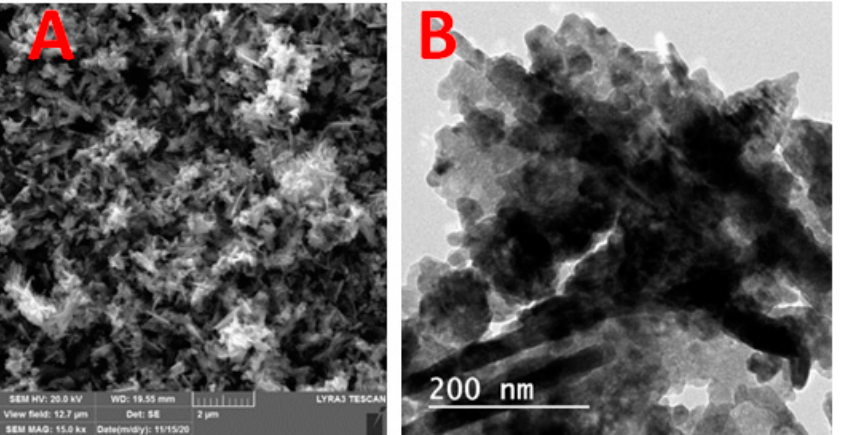
Figure 1. X-ray diffraction pattern of green biosynthesized ZnO NPs ( A ), FT-IR spectra of Ziziphus jujuba leaves extract and green biosynthesized ZnO NPs ( B ), and the zeta potential measurement of the green biosynthesized ZnO NPs ( C ).